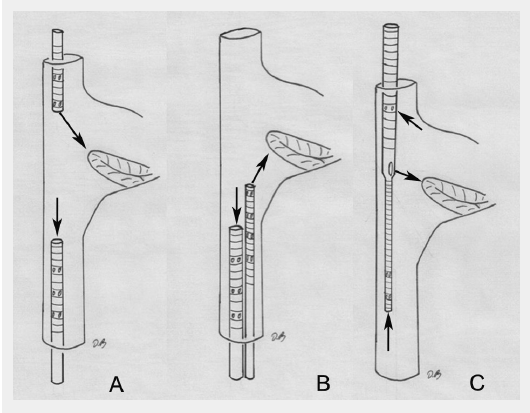
blood is delivered in the right atrium just in front of the tricuspid